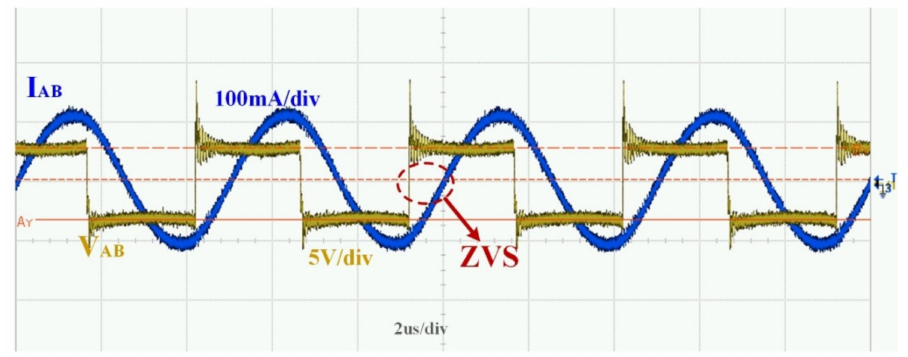
Figure 37. Inverter output voltage V AB and current I AB when ZVS.